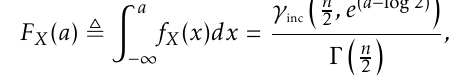
Figure 12. Optimal threshold τ simulations vs. M for different λ .